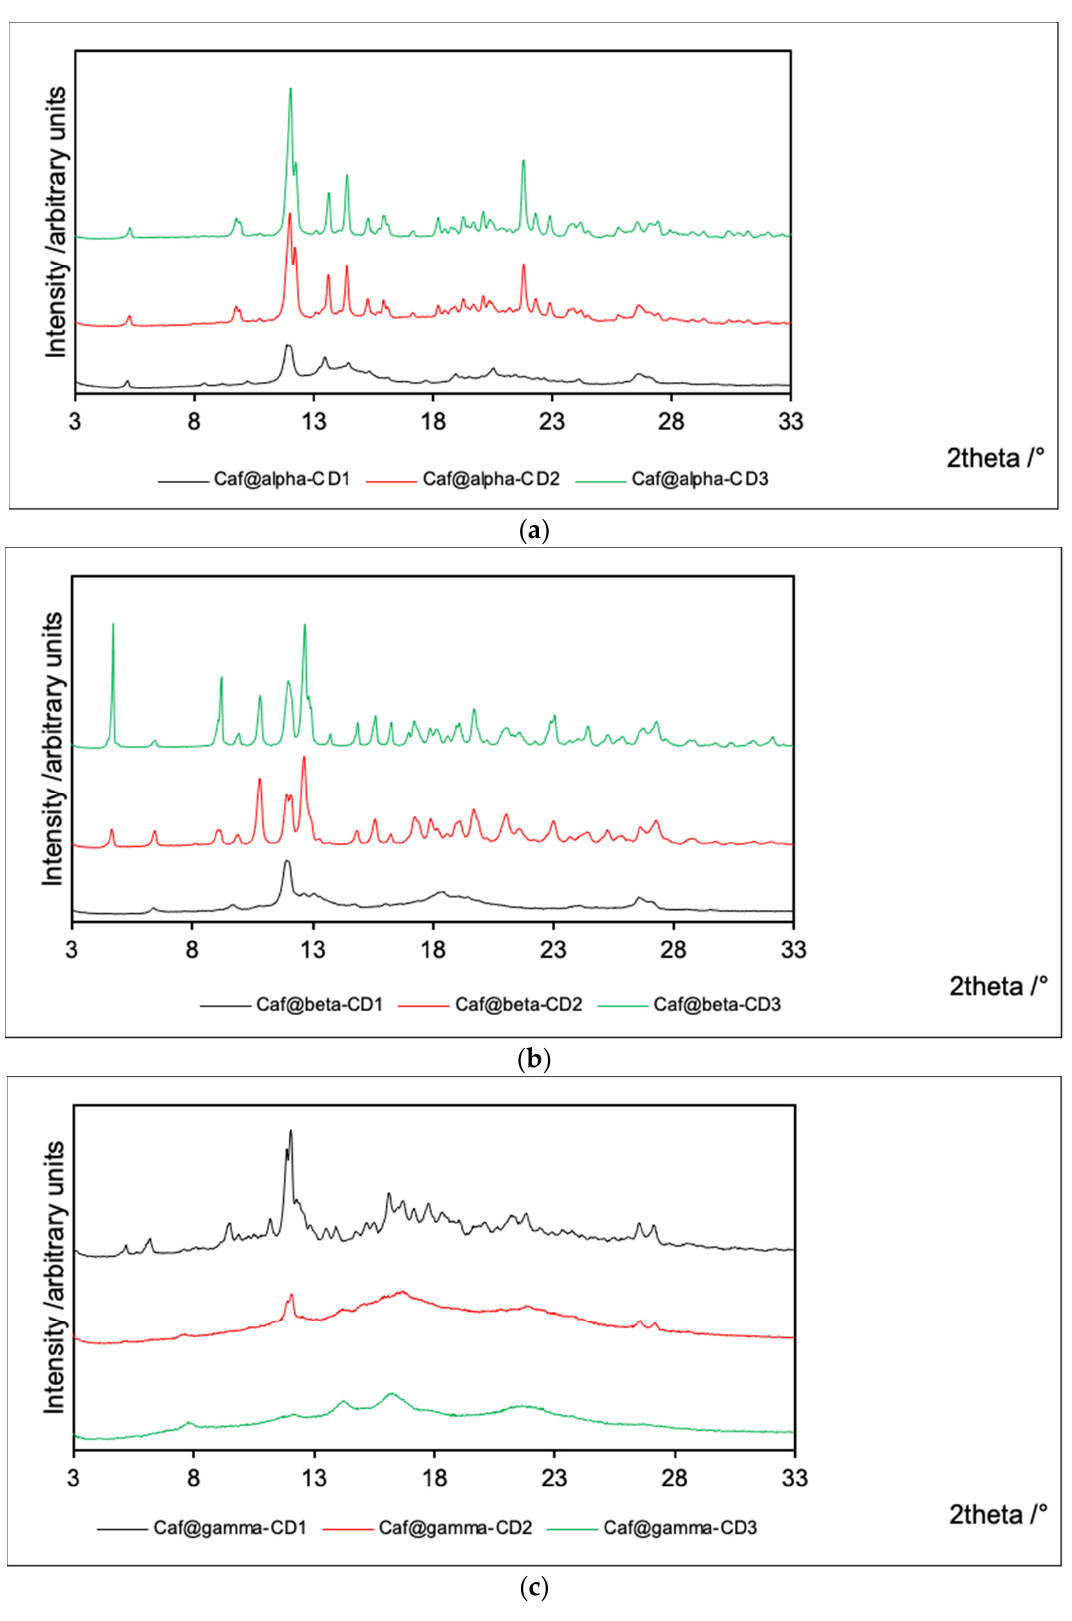
Figure 2. PXRD patterns for Caf@CD obtained by three methods (1: cogrinding; 2: cogrinding with the addition of water drops; and 3: depositing from soln.). ( a ) α-CD; ( b ) β-CD; and ( c ) γ-CD series.